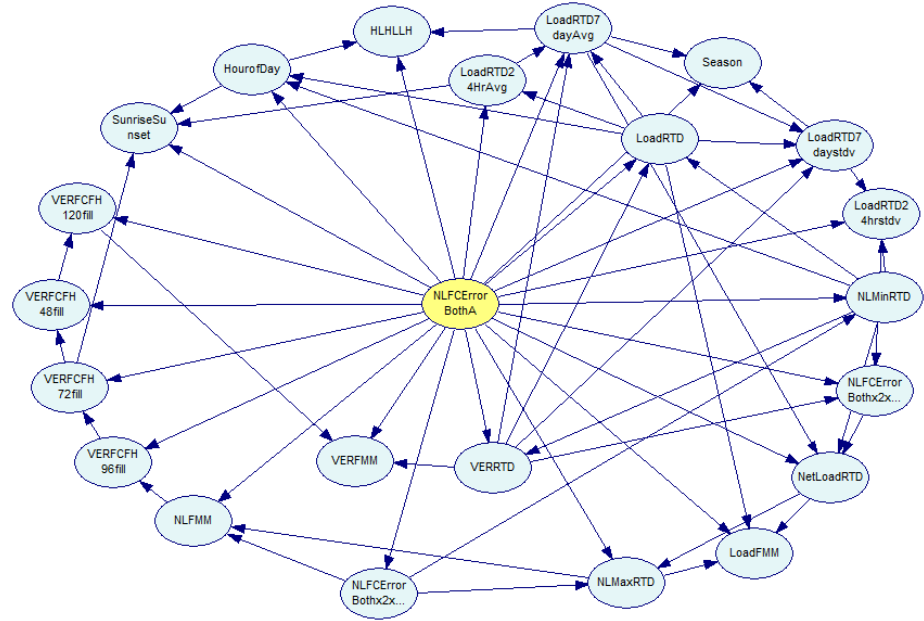
Figure 2. Best Overall BN.